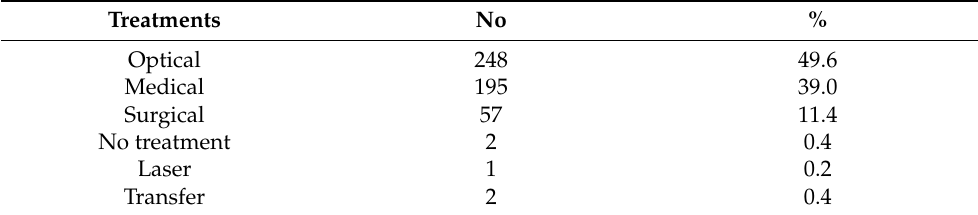
Table 4. Treatment